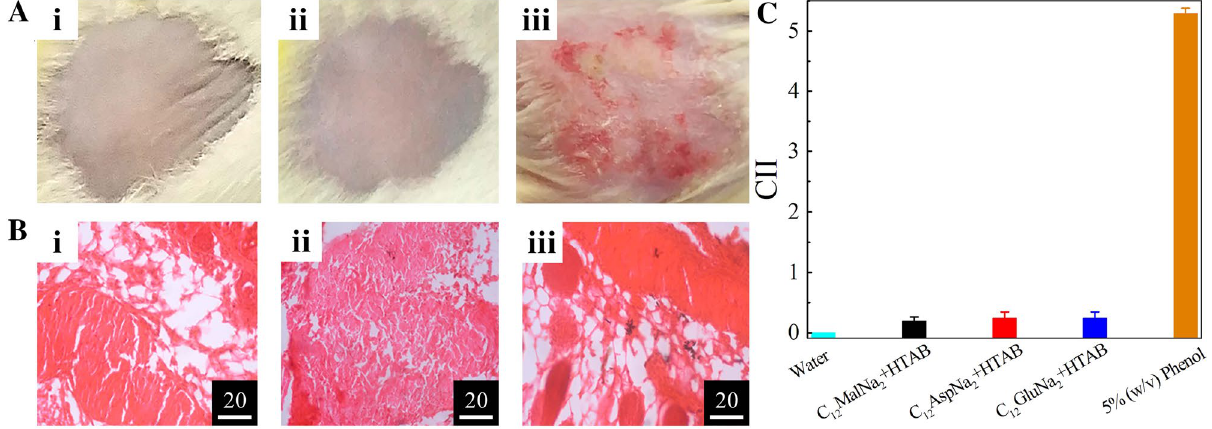
Figure 4. Effects of AAS + HTAB gels on mice skin. Gels were applied at the dorsal area of the trunk region of swiss albino mice for seven consecutive days and the effects recorded are presented through ( A ) photographs of treated skins and ( B ) corresponding histopathological evaluation of inflammation through micrographs. Systems: i, sterile distilled water (NC); ii, C 12 MalNa 2 + HTAB gel (100 mM, 60/40, M/M) and iii, 5% ( w / v ) phenol-water (PC). Micrographic scale bar: 20 μm. ( C ) cumulative irritancy index (CII) scores for skins treated with different systems, calculated according to Organization for Economic Co-operation and Development (OECD) guidelines 67 . Overall comparison of CII scores among the groups were carried out by the Kruskal– Wallis test followed by post-hoc Dunn’s test for multiple comparisons between each pair of groups. Significant differences in CII scores at P < 0.05 were obtained between groups PC vs. NC, PC vs. C 12 MalNa 2 + HTAB, PC vs. C 12 AspNa 2 + HTAB, and PC vs. C 12 GluNa 2 + HTAB gels.